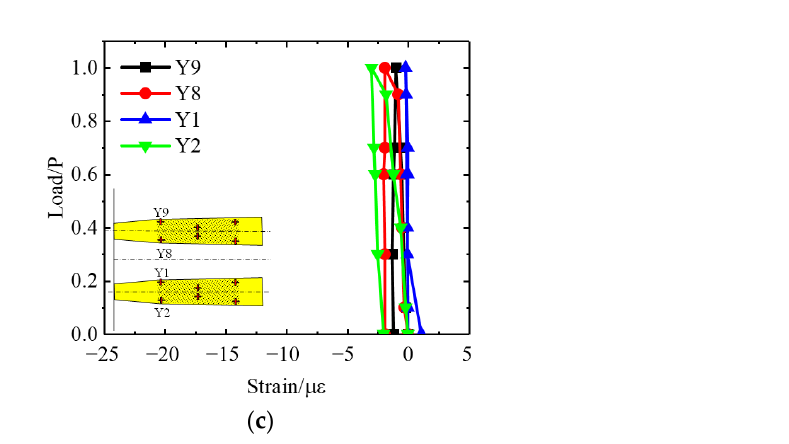
Figure 8. Design load Strain gauge deformation test results: ( a ) back anchor surface; ( b ) middle anchor; ( c ) front anchor.